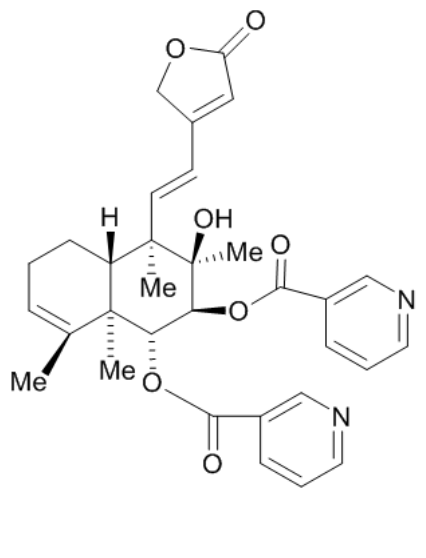
Figure 1. The chemical structure of scutebarbatine